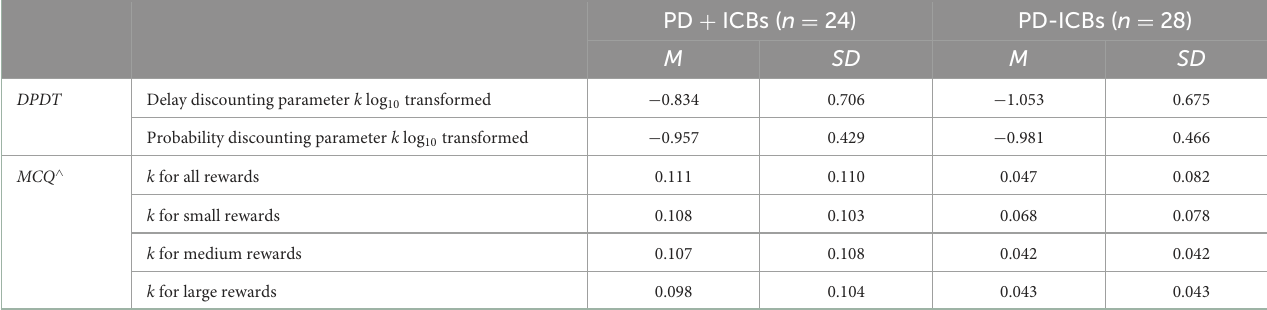
TABLE 3 Groups’ performance on choice impulsivity measures.